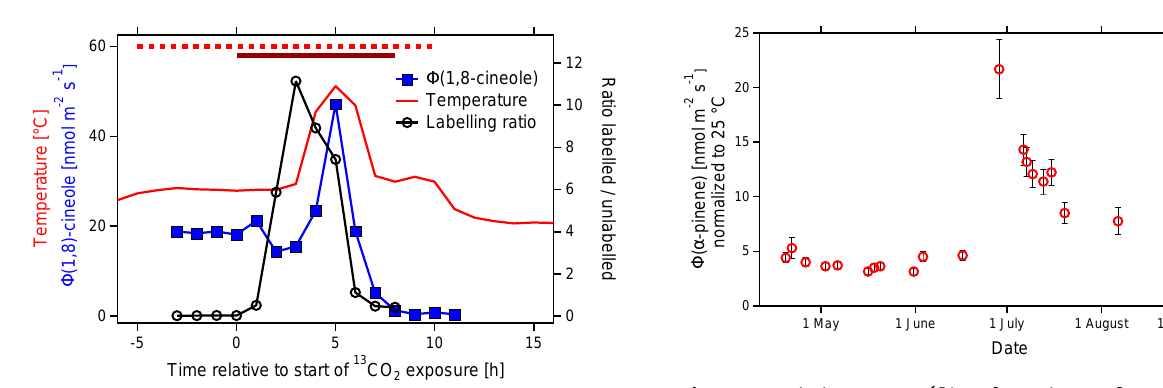
Fig. 3. Impact of high temperature stress on 1,8-cineole emissions from Scots pine (blue squares, left-hand scale). The red line shows the chamber temperature (left-hand scale). Open circles show the labelling ratio of 1,8-cineole molecules calculated according to Eq. (1), (right-hand scale). The red dashed bar shows the period of illumination (PPFD=800µmolm − 2 s − 1 ) , and the brown bar shows the period of 13 CO 2 exposure.